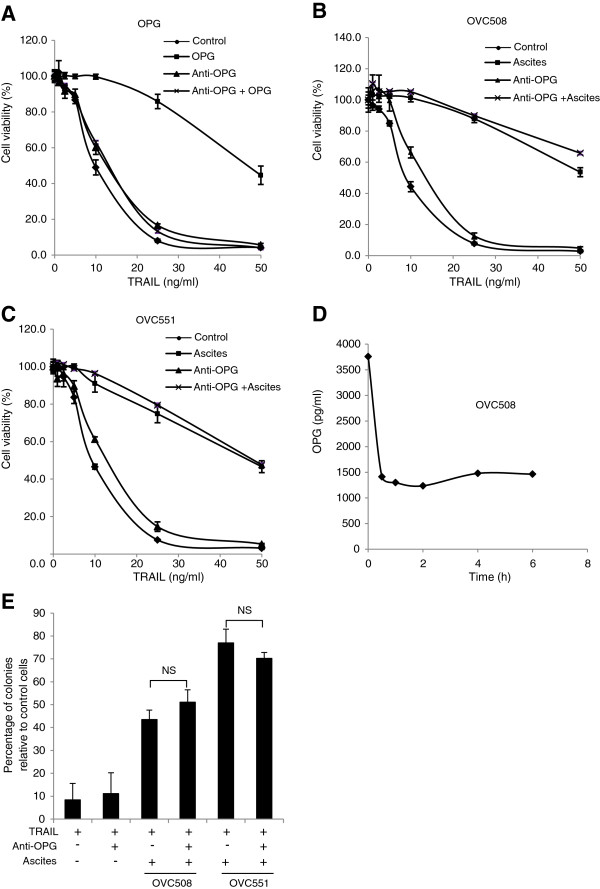
The anti-apoptotic effect of ascites cannot be reversed by OPG neutralizing antibodies. (A) CaOV3 cells were challenged with increasing concentrations of TRAIL and OPG (25 ng/ml) in the presence or absence of anti-OPG antibodies (10 μg/ml) for 48 h. Cell viability was determined by XTT assay and expressed as the percentage relative to control (untreated) cells. CaOV3 cells were challenged with TRAIL, OVC508 ascites (10%) (B) or OVC551 ascites (10%) (C), in the presence or absence of anti-OPG antibodies (10 μg/ml) for 48 h. Cell viability was assessed as above. (D) OVC508 ascites was incubated with anti-OPG antibodies (10 μg/ml) for up to 6 h. Protein G agarose was then added for 1 h and centrifuged and OPG levels were determined in the supernatant by ELISA. (E) CaOV3 cells were challenged with TRAIL (10 ng/ml), ascites (10%) and anti-OPG (10 μg/ml) for 48 h. The cells were washed and fresh medium was added. Viable colonies were counted after 14 days and data were expressed as% of colonies in control (untreated) cells. Data are expressed as means of triplicates from three independent experiments ± SD. NS indicates that differences did not reach statistical significance with P > 0.05.